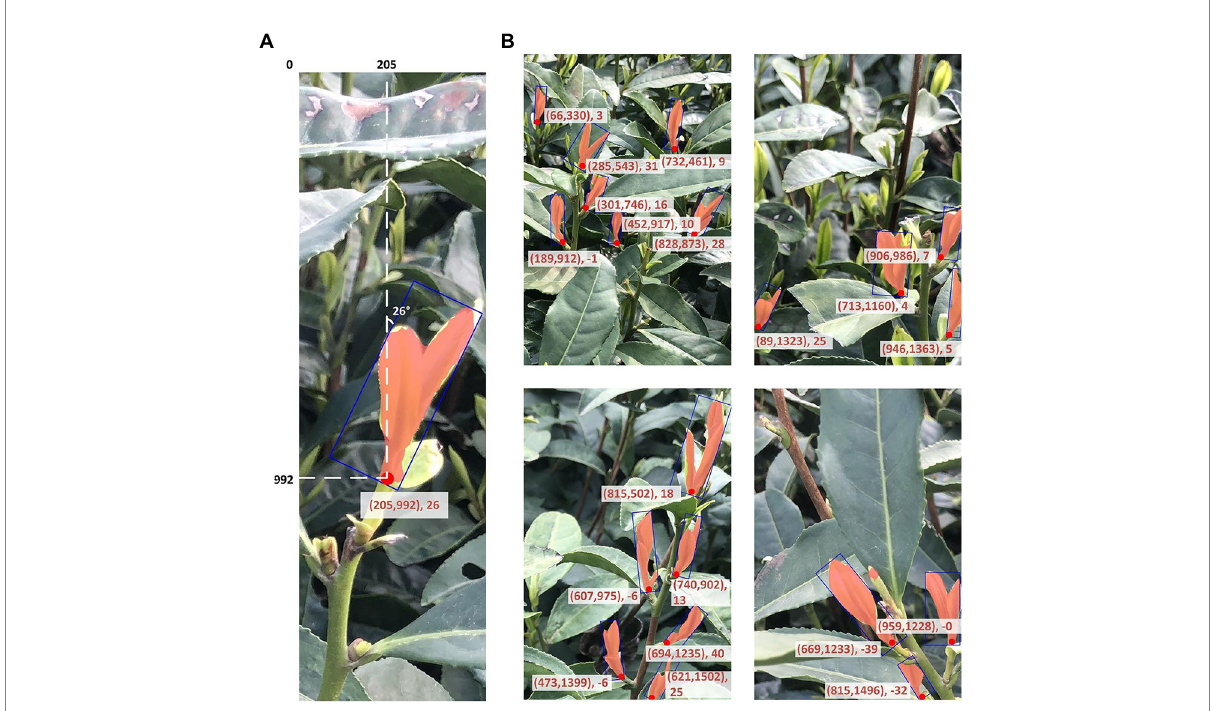
FIGURE 8 Examples of the resulting outcome of the MR3P-TS model (A) a single sample example of the shoot output, and (B) four images showing multiple tea shoots and picking point identification from the MR3P-TS